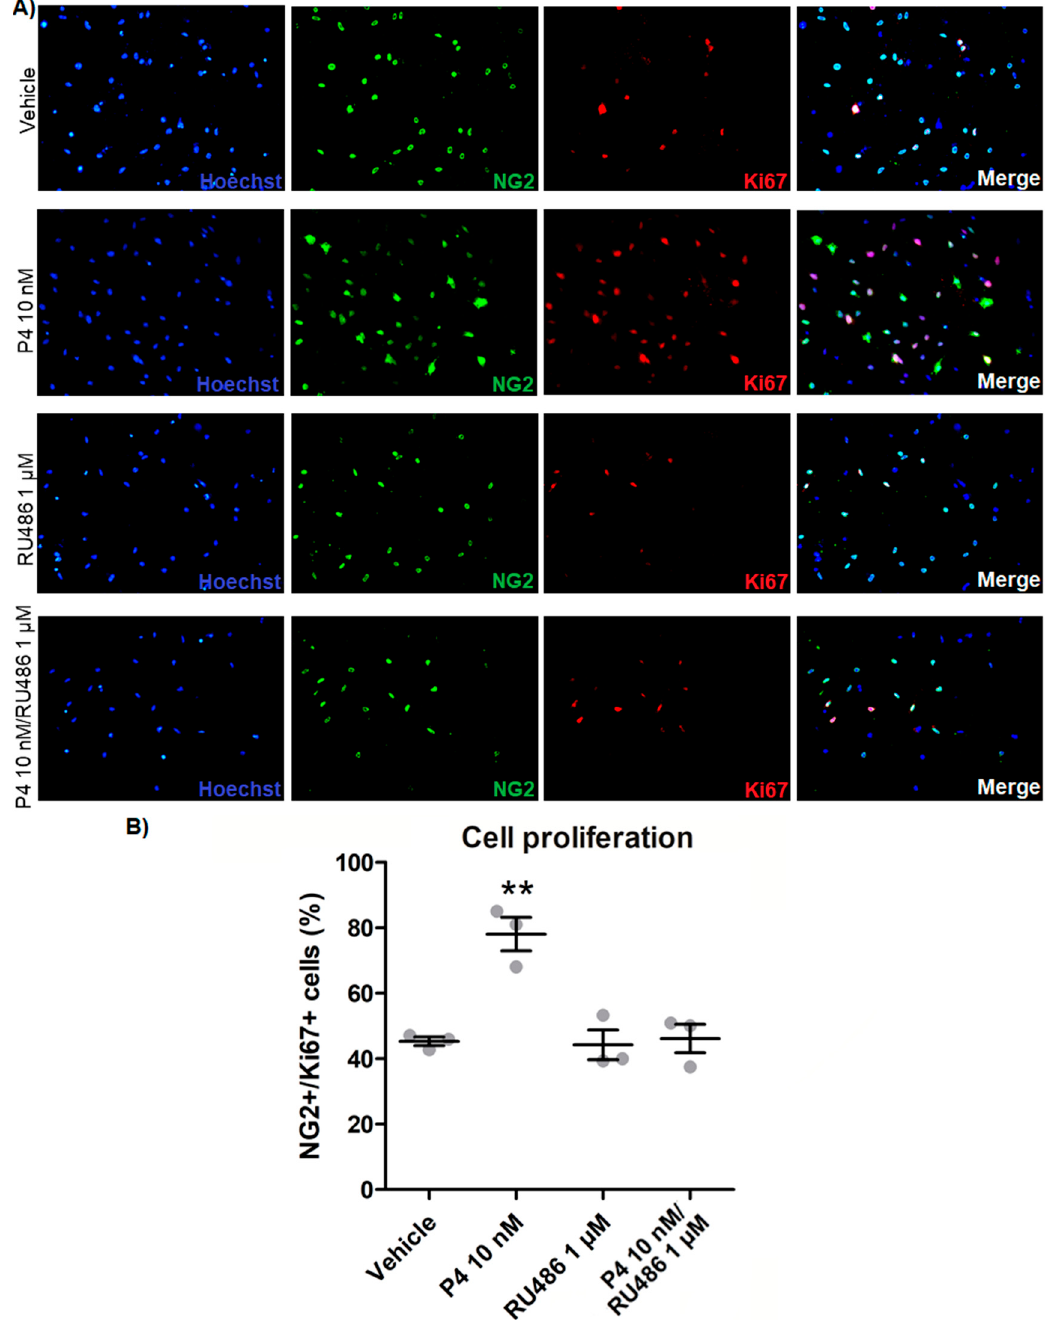
Figure 2. Progesterone increases embryonic OPC proliferation. ( A ) NG2 / Ki67 immunostaining in OPC cultured with growth factors and treated with progesterone (P4; 10 nM), RU486 (1 µ M), P4 (10 nM) and RU486 (1 µ M), and vehicle (DMSO 0.01%), for 3 days. ( B ) Graph derived from the percentage of NG2 / Ki67-positive cells observed in the immunofluorescence experiments. The percentage of NG2 +/ Ki67 + cells was determined as a percentage of the total number of cells stained with Hoechst. Results are expressed as the mean ± standard error of the mean (S.E.M.); n = 3; ** p < 0.01 vs. the rest of the groups.